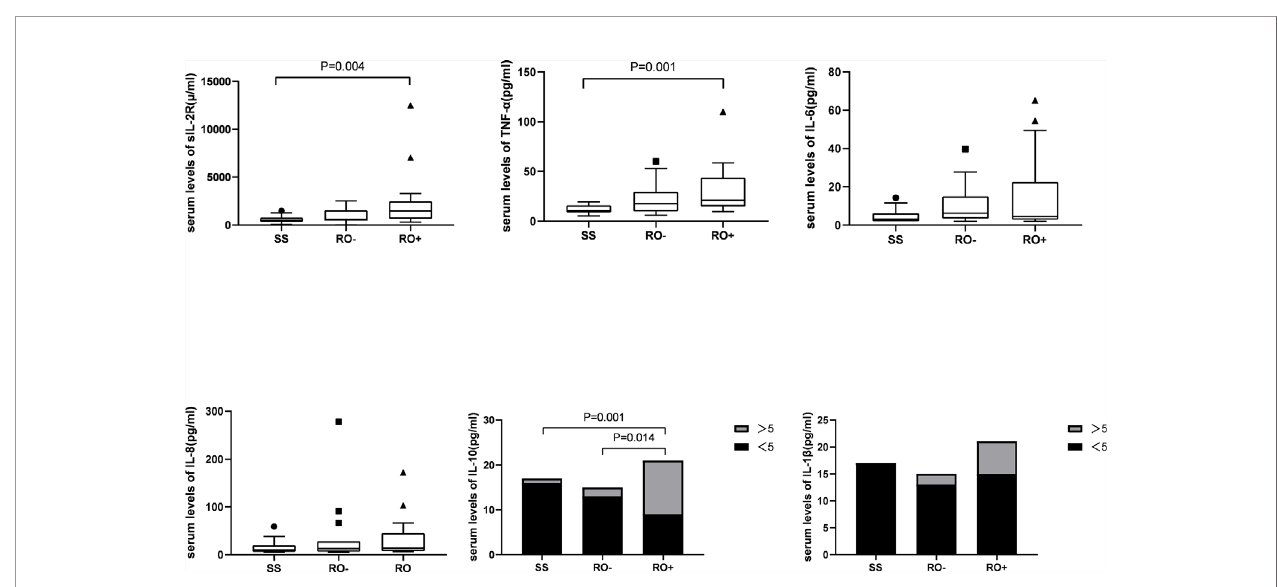
FIGURE 2 | The lymphocyte subset in disease classi fi